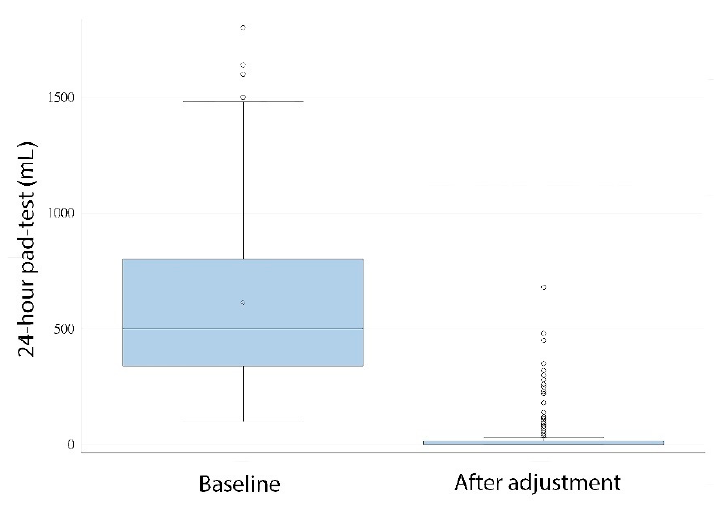
Figure 1. The 24-h, pad-test baseline compared to after adjustment ( t -test, p < 0.0001).